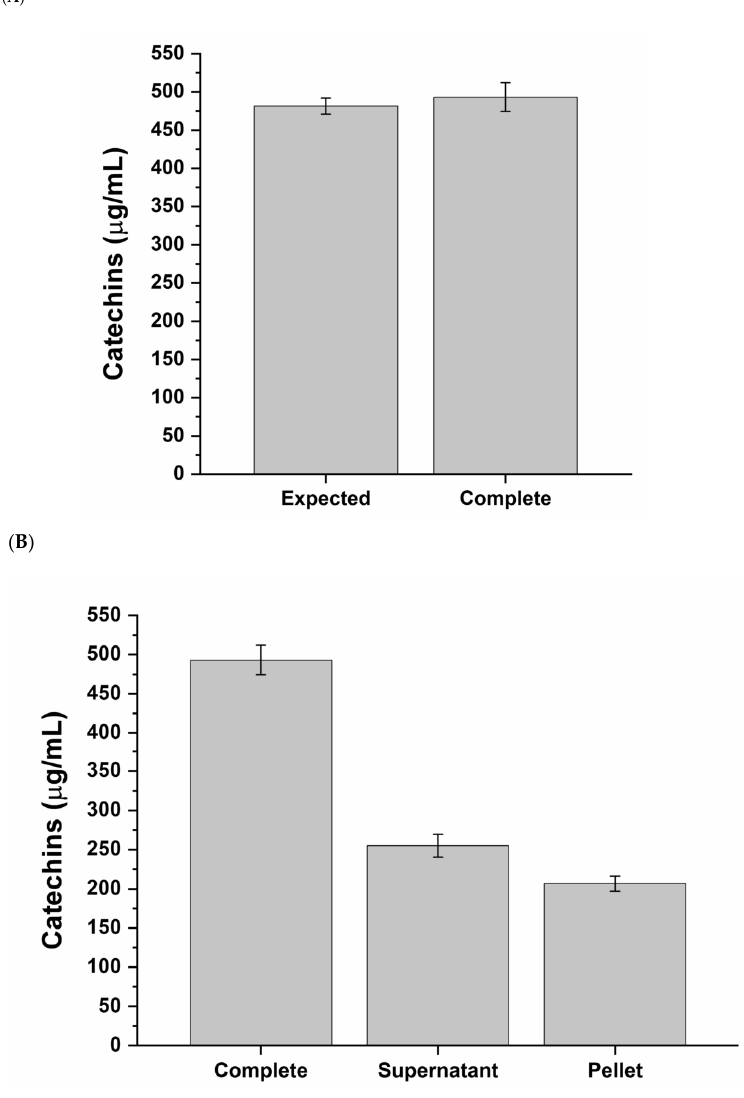
Figure 1. Catechins content of Abigenol ® /AlbiPhenol ® ( A ) at the end of the processing phase and ( B ) in the supernatant and pellet fractions. Table 1. Abigenol ® /AlbiPhenol ® catechin (CTCN) content at the end of the processing phase and in the supernatant (bioaccessible fraction) and pellet (excreted fraction). Percentages are calculated on